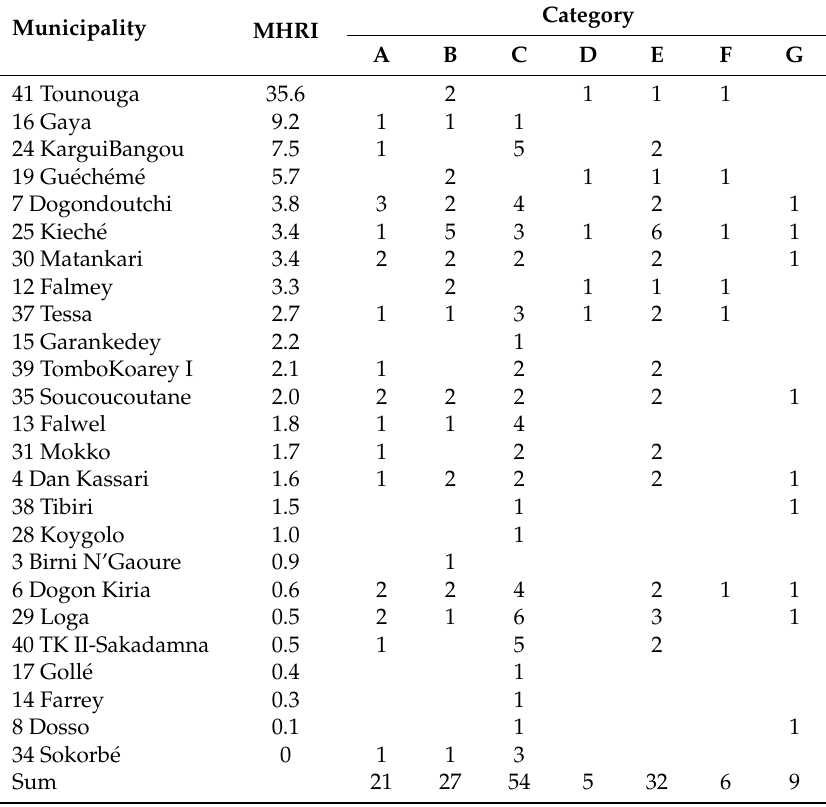
Table 7. The number of adaptation actions developed by 12 projects in each municipality grouped according the categories proposed by [84] and compared with the level of multihazard risk. Municipality